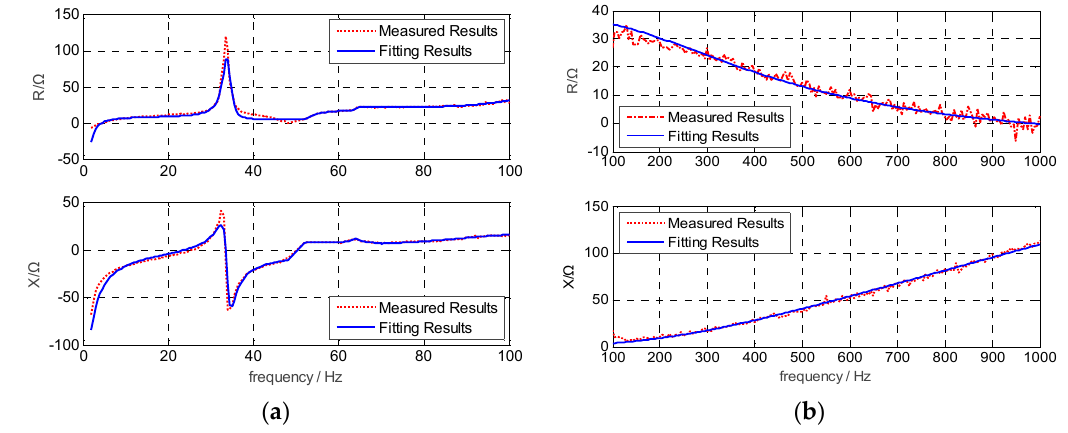
Figure 8. Impedance–frequency characteristic of an MMC: ( a ) 0–100 Hz; ( b ) 100–1000 Hz.